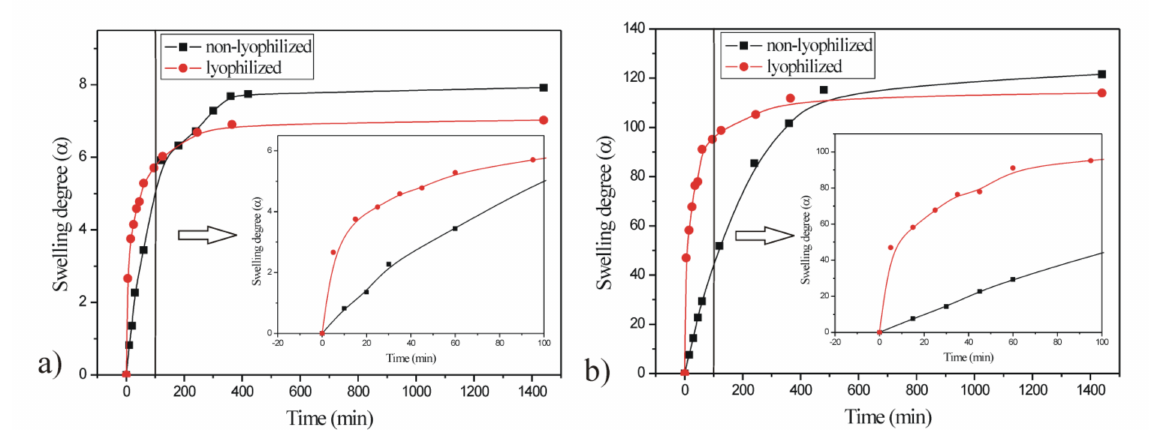
Figure 10. Dependence of the swelling degree of the p(NIPAM-co-AA) hydrogel before and after lyophilization on time at 37 ◦ C and ( a ) pH 3.5 and ( b ) 8.5.